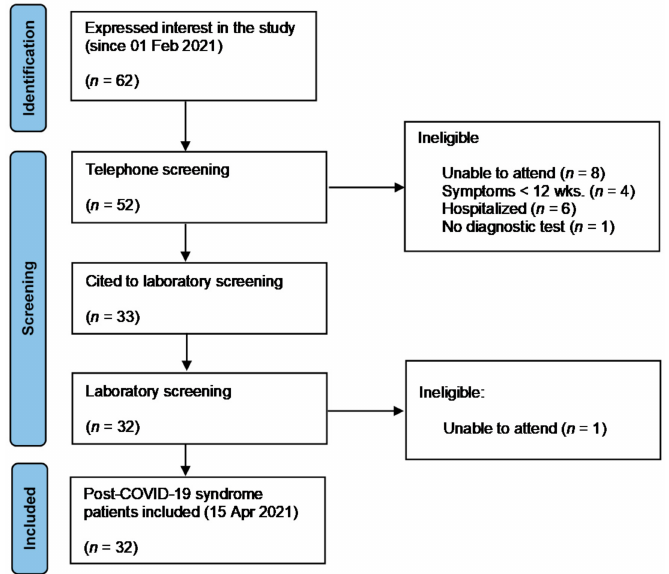
Figure 1. PRISMA flow diagram of recruitment